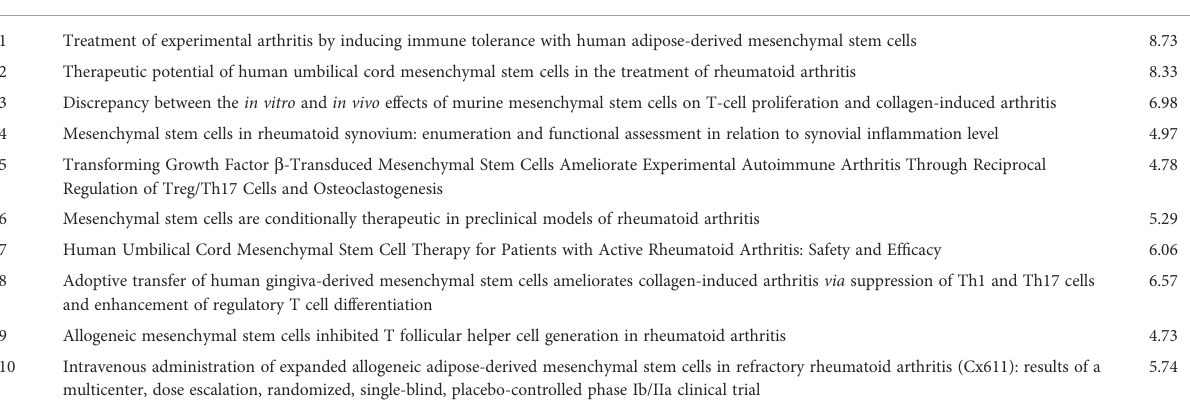
Intravenous administration of expanded allogeneic adipose-derived mesenchymal stem cells in refractory rheumatoid arthritis (Cx611): results of a multicenter, dose escalation, randomized, single-blind, placebo-controlled phase Ib/IIa clinical